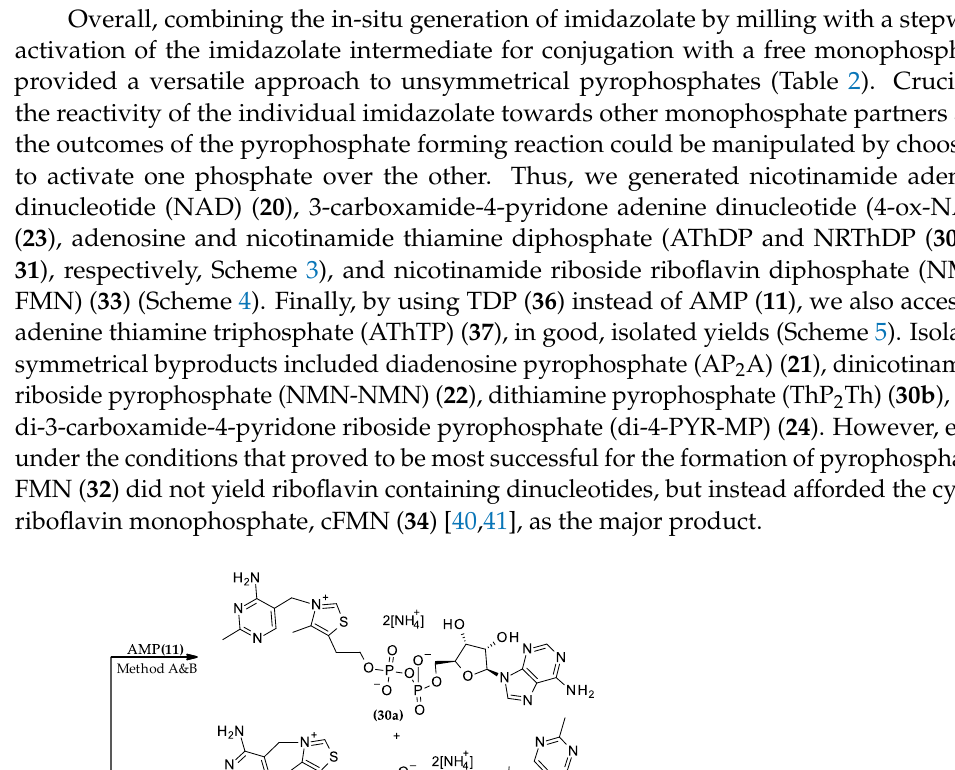
n.d. = not determined; a = 1 H-NMR, b = 31 P-NMR; c = mixture of pyrophosphates; d = free acid form; * = Ammonium salt; SP: solution phase; BM: Ball milling, ON: overnight; ^: non isolated component, e = 28µL, 0.6 µL/mg of monophosphate .